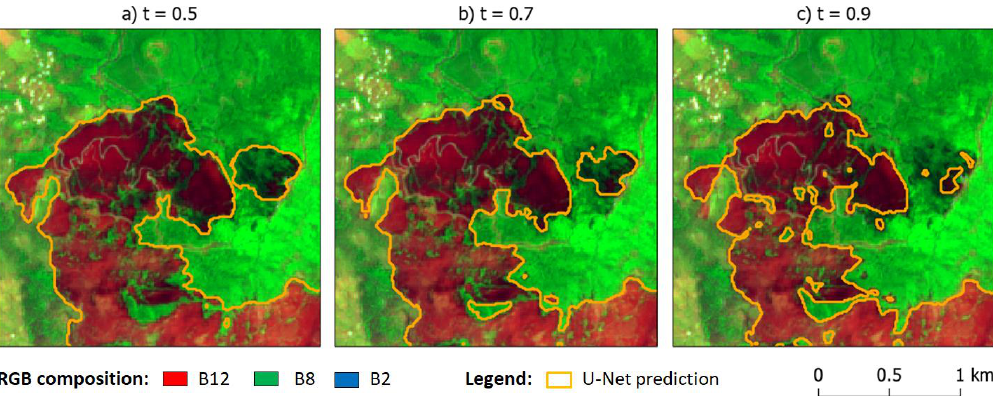
Figure 12. U-Net predictions using different probability thresholds t to predict a pixel as burned. ( a ) t = 0.5; ( b ) t = 0.7; ( c ) t = 0.9.